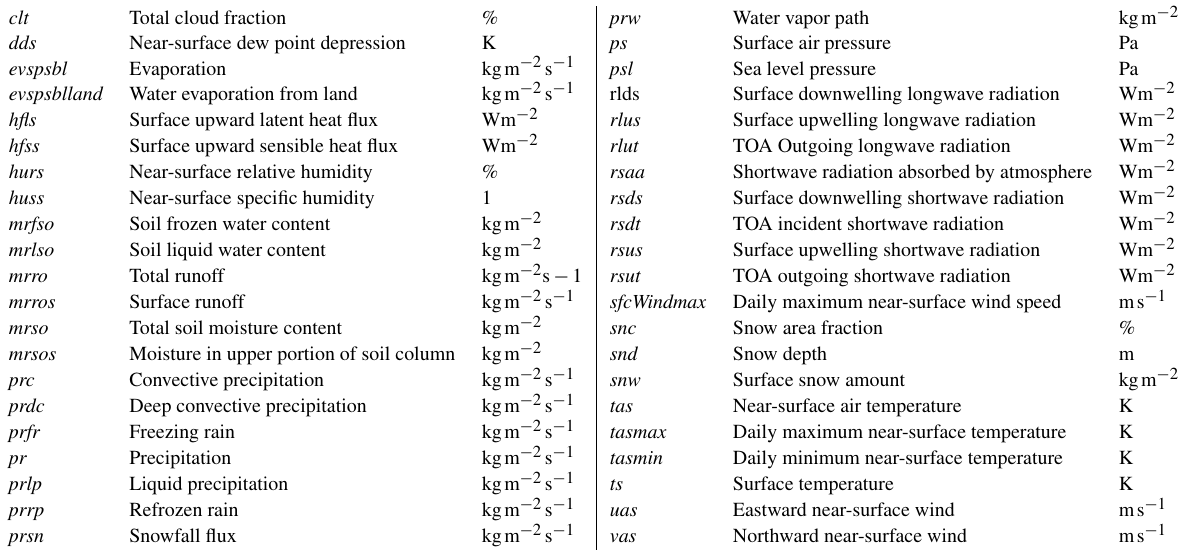
Table 1. The 42 monthly atmospheric and soil variables from CRCM5-LE. TOA refers to top of atmosphere. clt Total cloud fraction